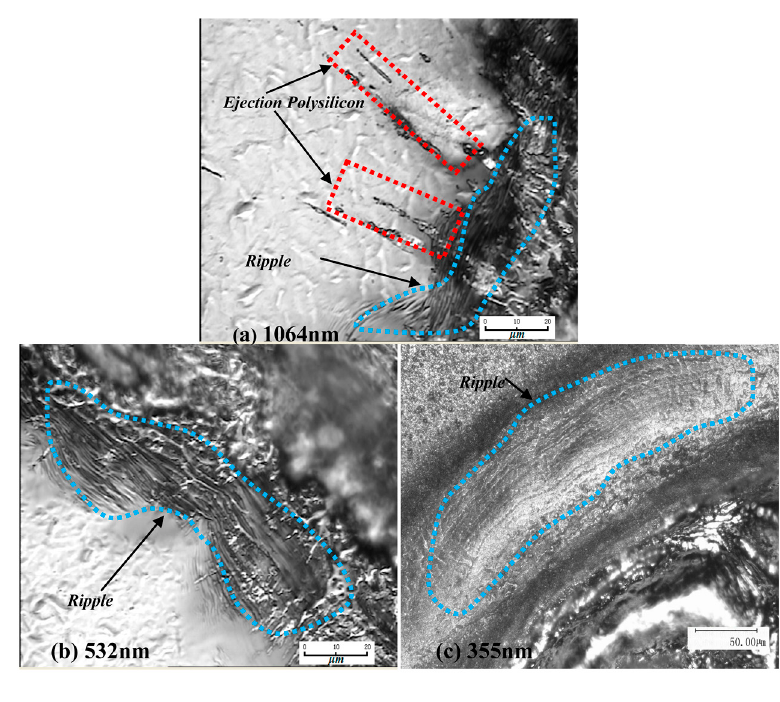
Figure 2. The ripples of three wavelengths after laser irradiation.